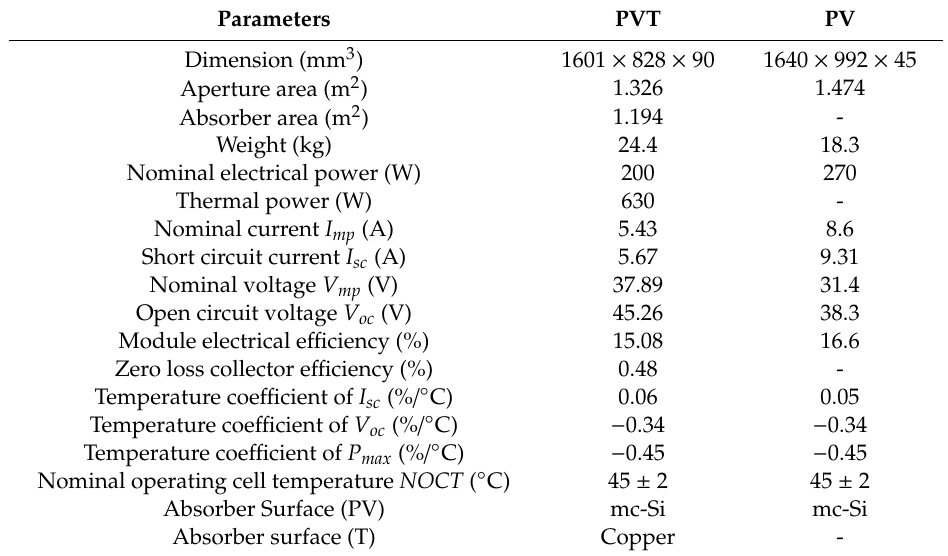
Figure 1. ( a ) Conventional solar photovoltaic (PV) installation; ( b ) hybrid photovoltaic-thermal (PVT) installation. Table 1. Technical specification of PVT and PV collectors.